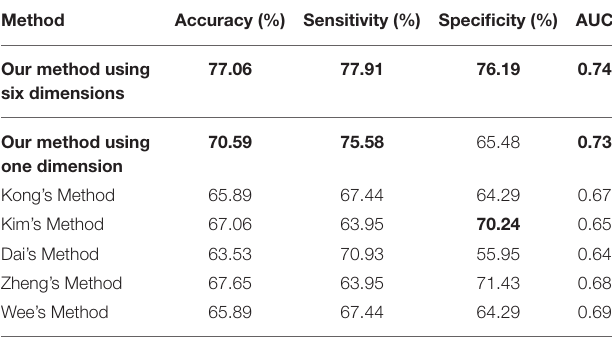
TABLE 5 | Classification performance of different methods to distinguish sMCI and